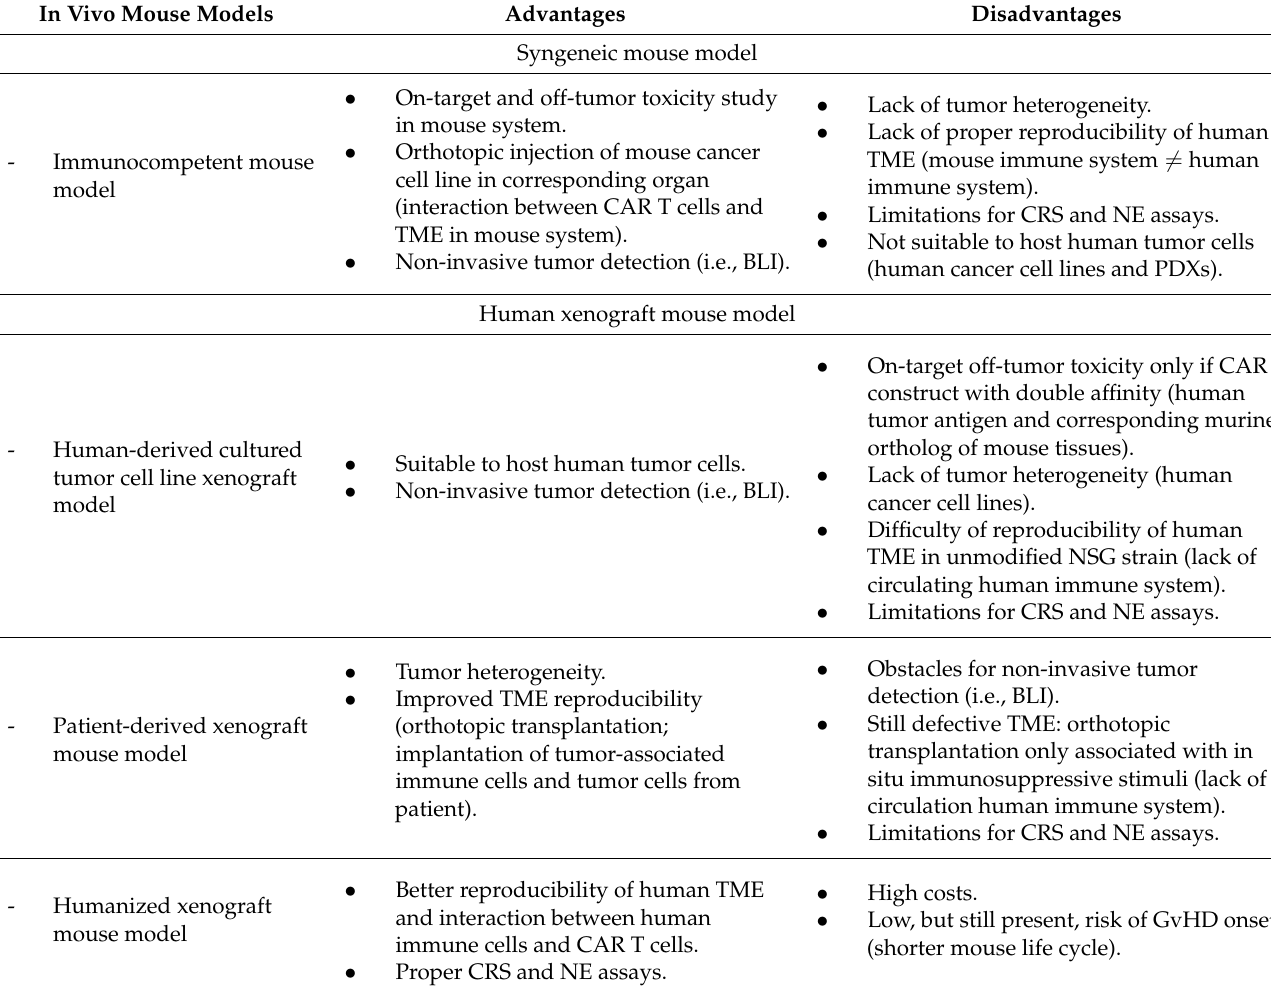
Table 1. Benefits and limitations of in vivo model